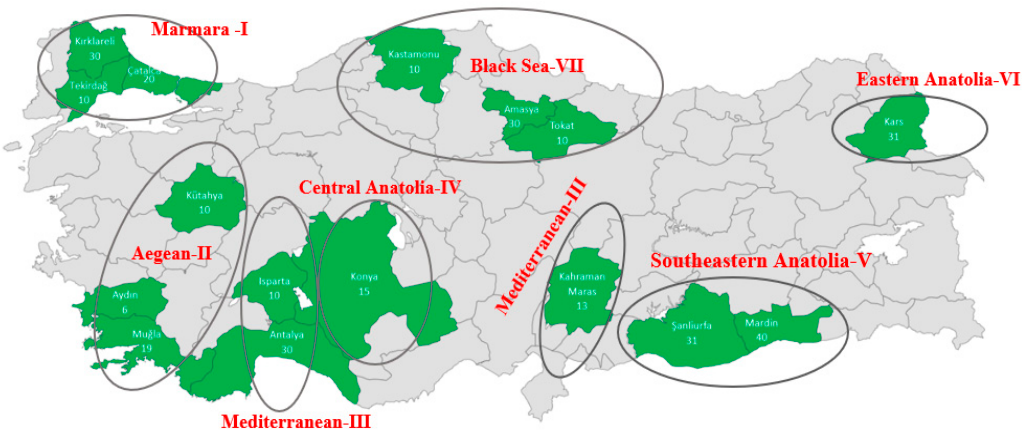
Figure 1. Turkish indigenous donkey populations, sampling areas from the seven different regions of geographical regions of Turkey.